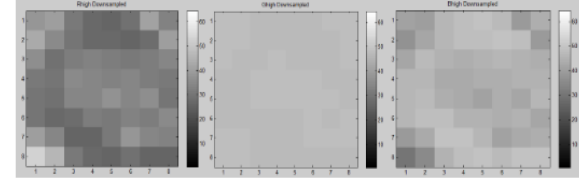
Figure 12. Downsampling of 32 × 32 pixels multispectral gives 8× 8 pixels .